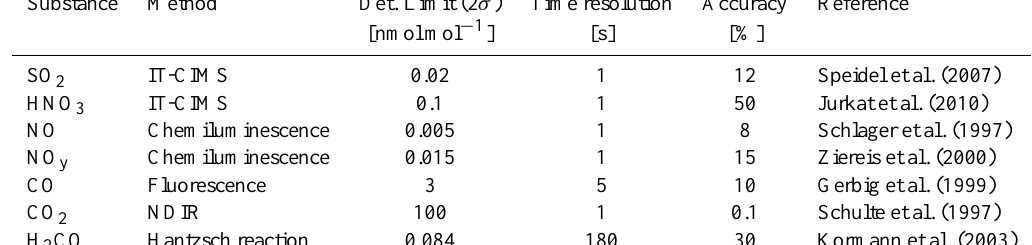
Table 2. Compilation of gas phase instruments deployed on the Falcon during AMMA. Also compiled are detection limits and uncertainties.